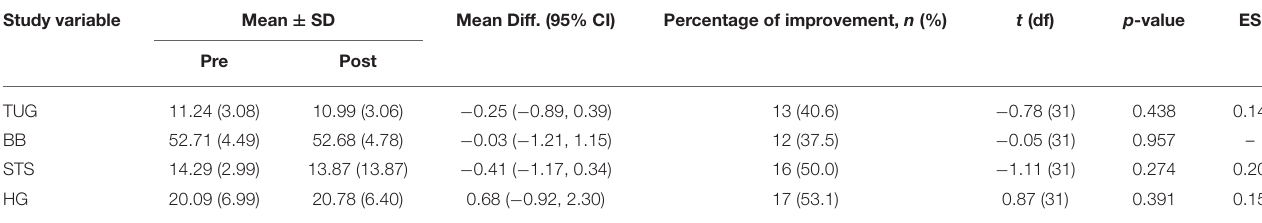
TABLE 3 | Pre- and post-intervention comparisons using paired t-test for timed up and go, Berg balance, sit-to-stand, and hand grip strength measurement. Study variable Mean ±